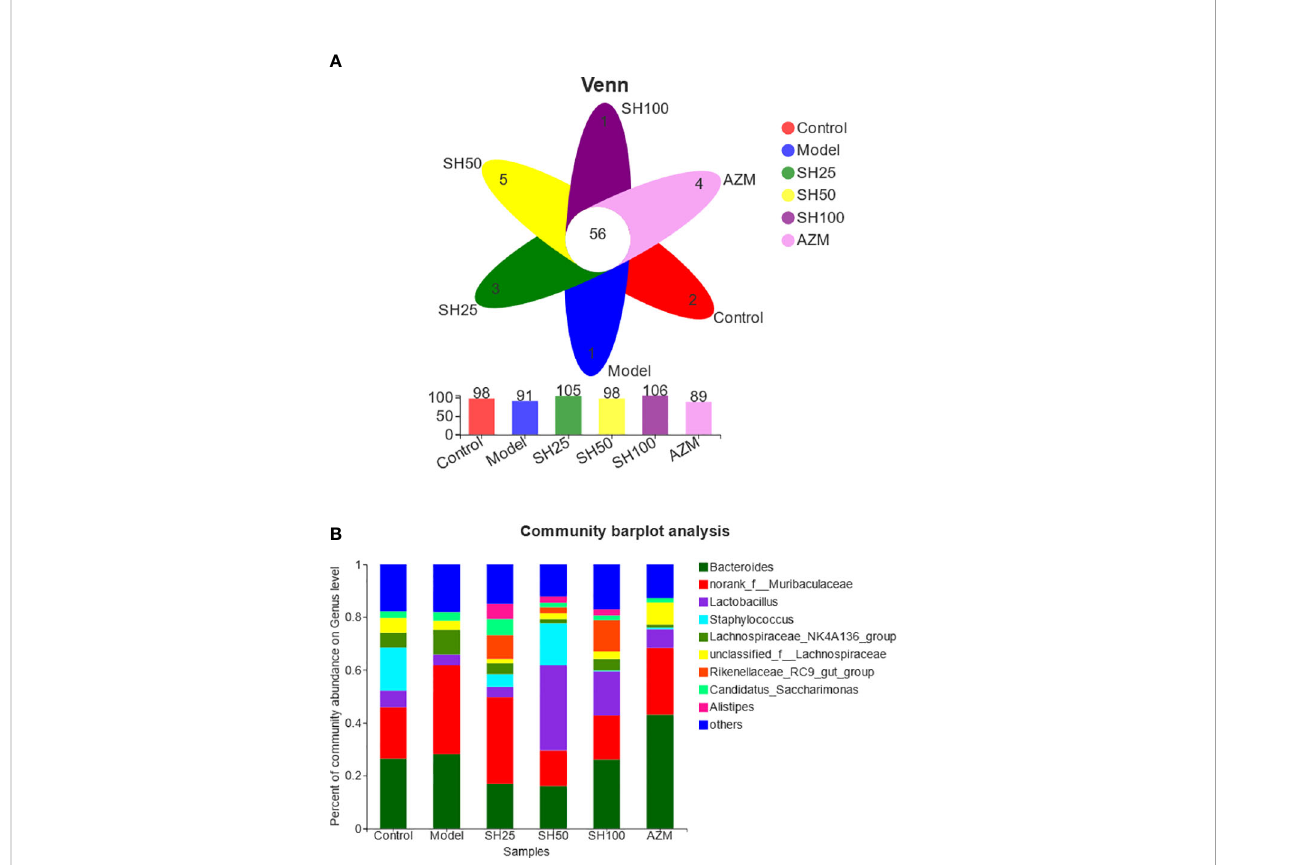
FIGURE 5 Analysis of species composition of gut microbiota. (A) Venn diagram: Different colors represent different populations (or samples), overlapping portions represent species common to multiple populations (or samples), non-overlapping portions represent species-speci fi c to that population (or sample), and numbers indicate the corresponding number of species. (B) Community barplot histogram at genus level. Control group represents the control group without any treatment, Model, P. aeruginosa without any drug treatment. SH25, SH50 and SH100 mean SH 25 mg/kg, SH 50 mg/kg and SH 100